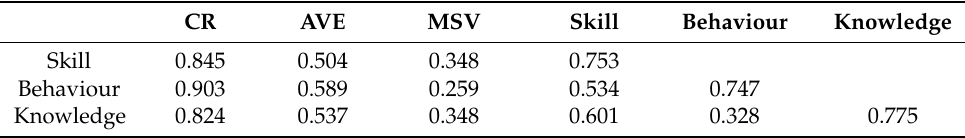
Table 7. Reliability and validity analysis for competencies. CR AVE MSV Skill Behaviour Knowledge Skill